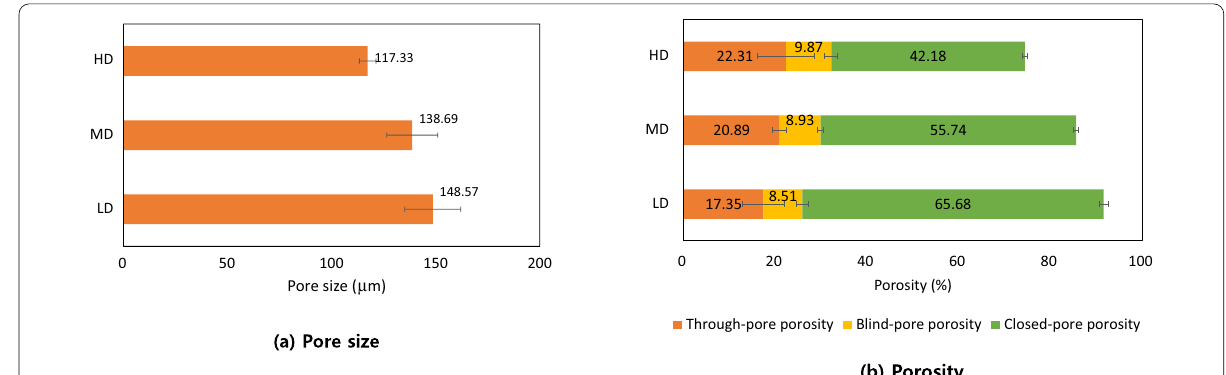
Fig. 3 Results of porosity analysis of balsa depending on density. a Pore size, b